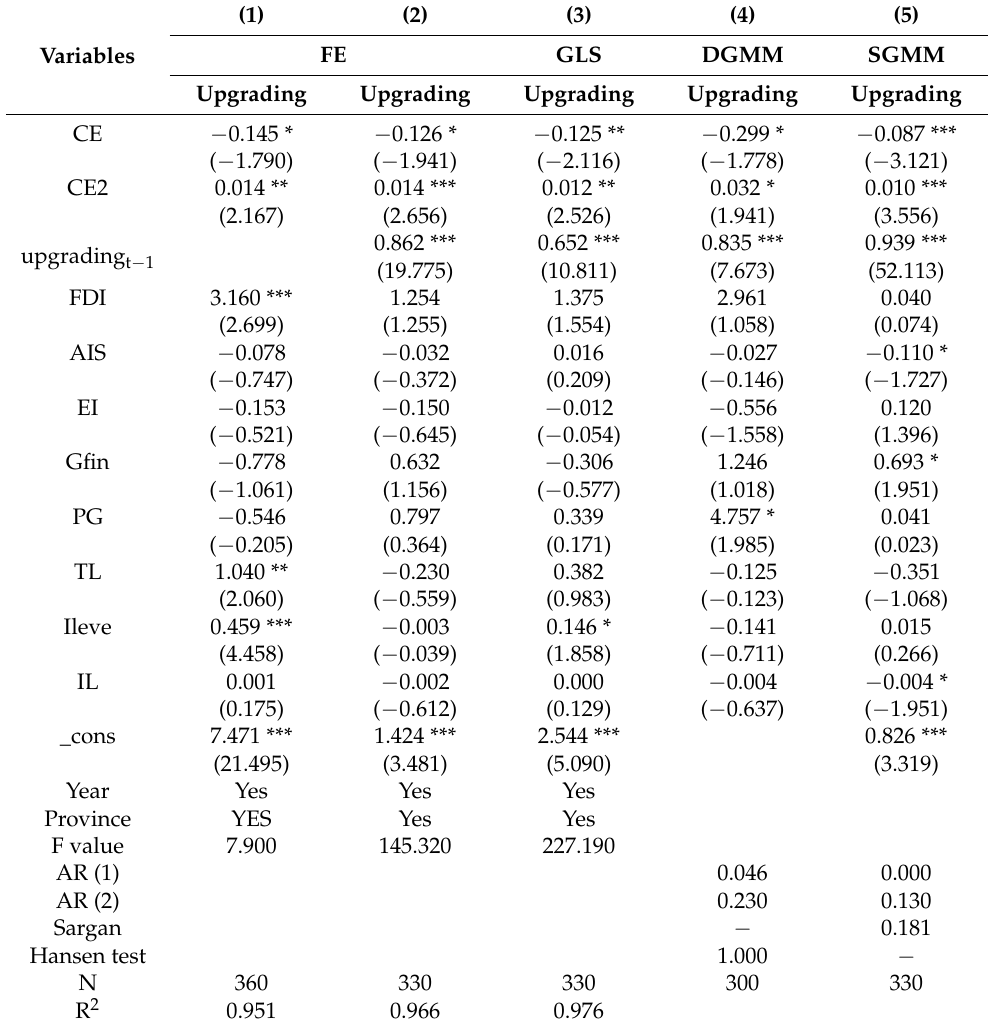
Table 7. Robustness test results for the dynamic